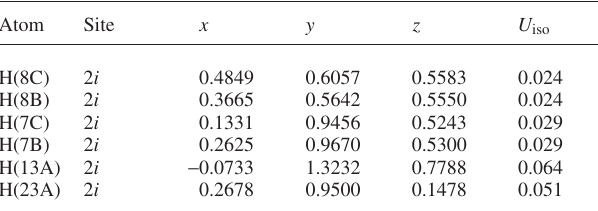
Table 2. Atomic coordinates and displacement parameters (in Å 2 )